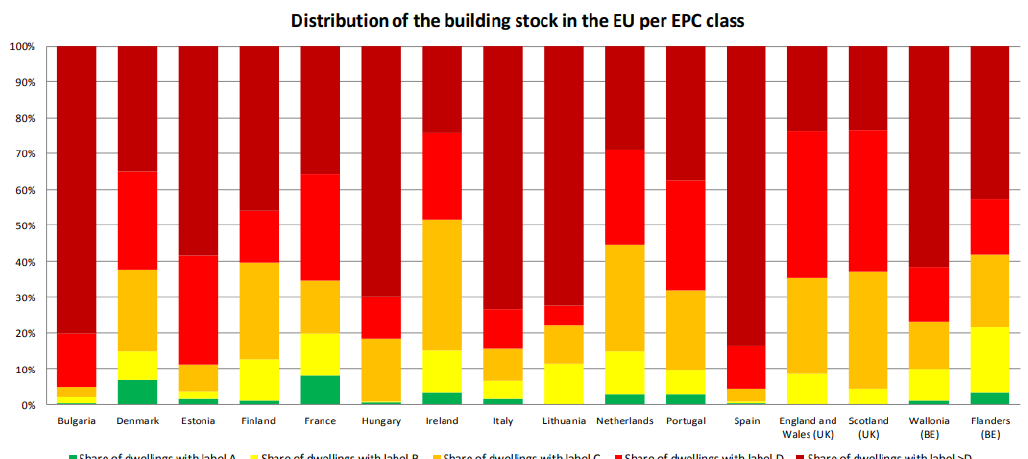
Figure 1. Classification of the building stock, according to energy efficiency, on a scale of A (the best) to >D (the worst), for several European countries [24].